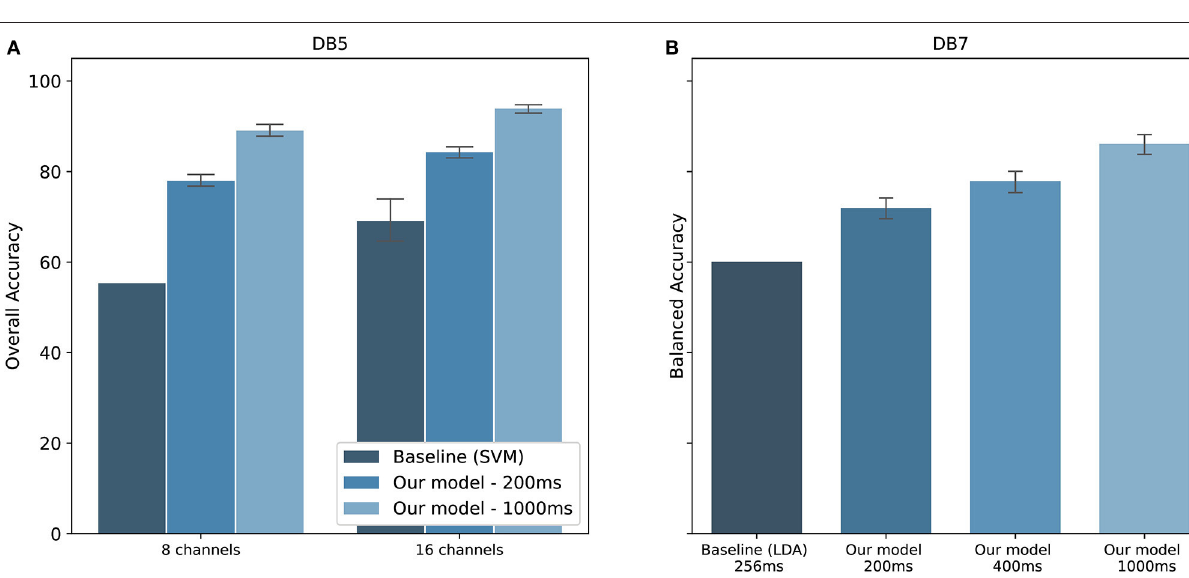
FIGURE 8 | Performance comparison with baseline studies for the classification of 41 hand movements. (A) Overall accuracy of our model on DB5 compared to Pizzolato et al. (2017). (B) Balanced accuracy on DB7 compared to Krasoulis et al. (2017). The standard deviations for the baseline prior works using eight channels of DB5 and 256 ms of DB7 were not